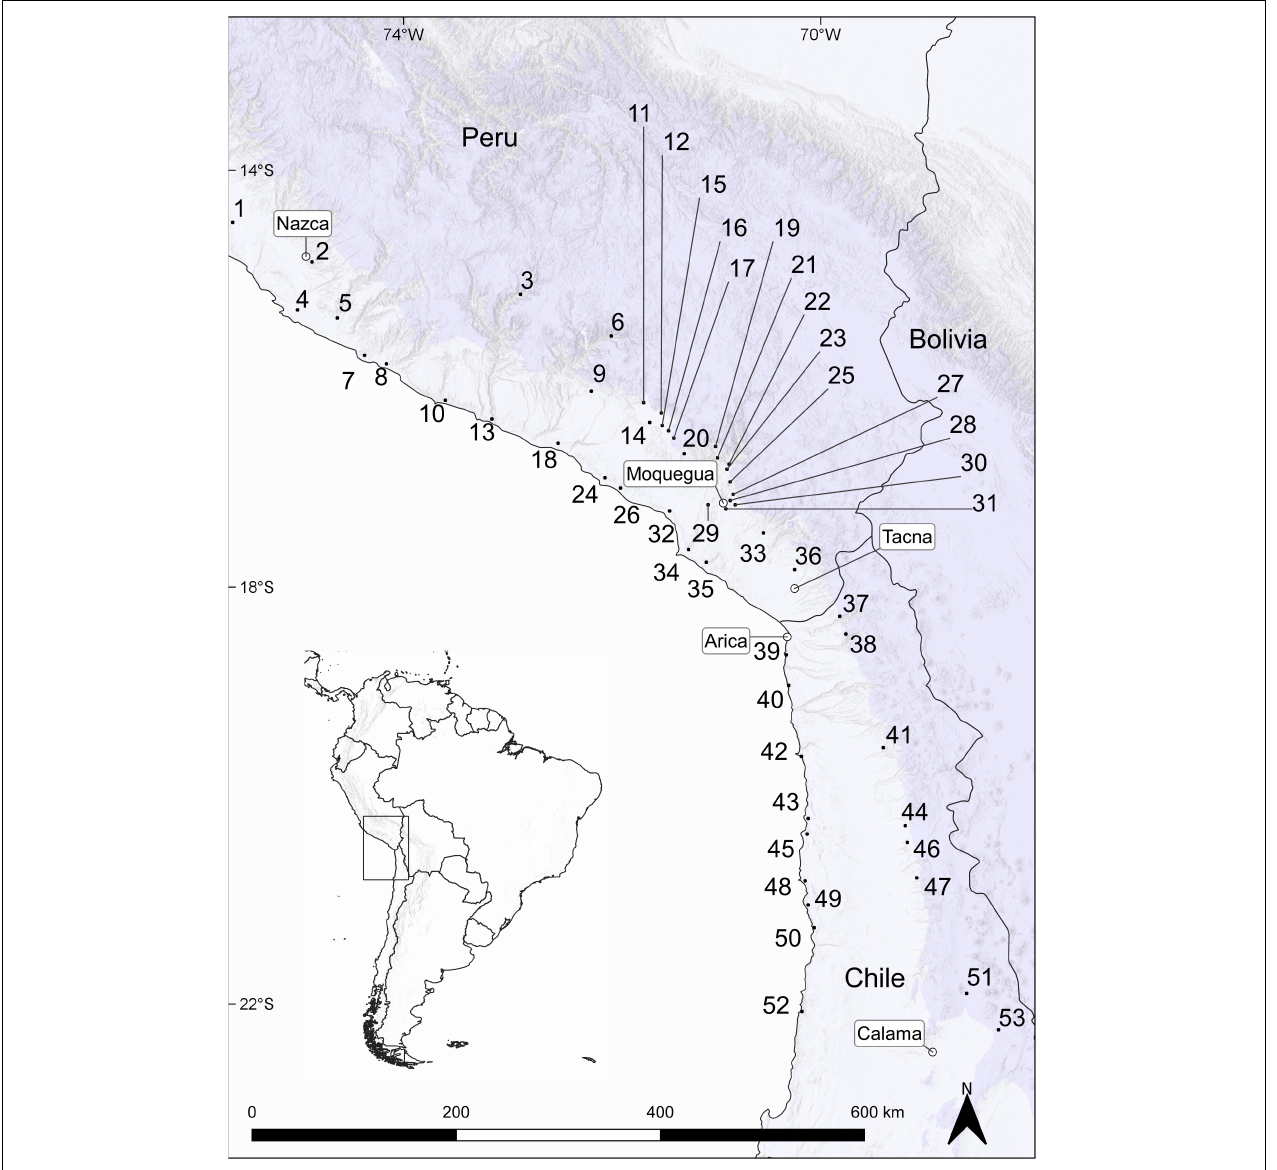
FIGURE 1 | Coastal and Andean desert locations in southern Peru and northern Chile. Map was created in QGIS 3.14.16. Country layers were taken from Natural Earth (www.naturalearthdata.com). City layers were taken from MapCruzin (www.mapcruzin.com). Hillshade layer was taken from ESRI (Environmental